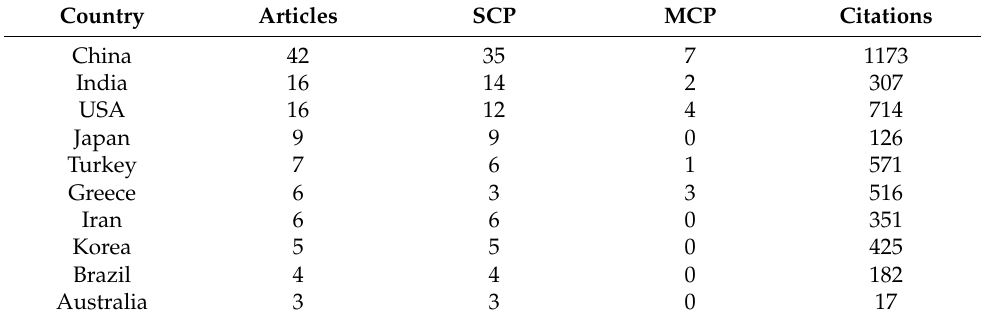
Table 2. Top 10 most contributing countries.